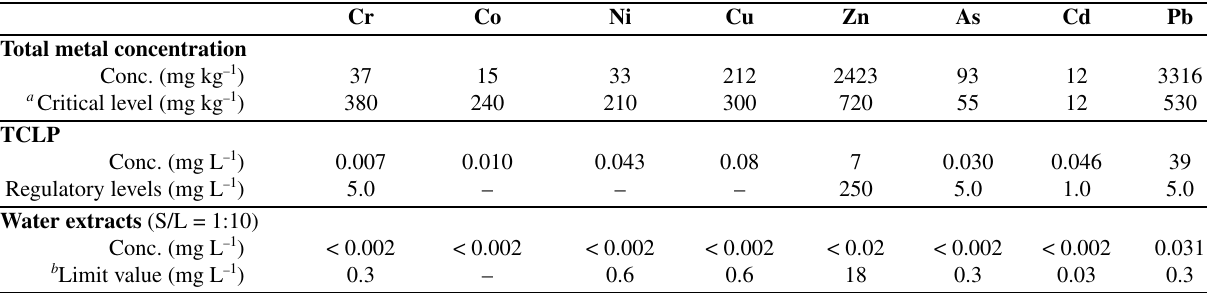
Table 2: Total metal concentration (mg kg –1 ), TCLP (mg L –1 ) and water extractable (mg L –1 ) metal concentrations in tailings with the correspon- ding legislative